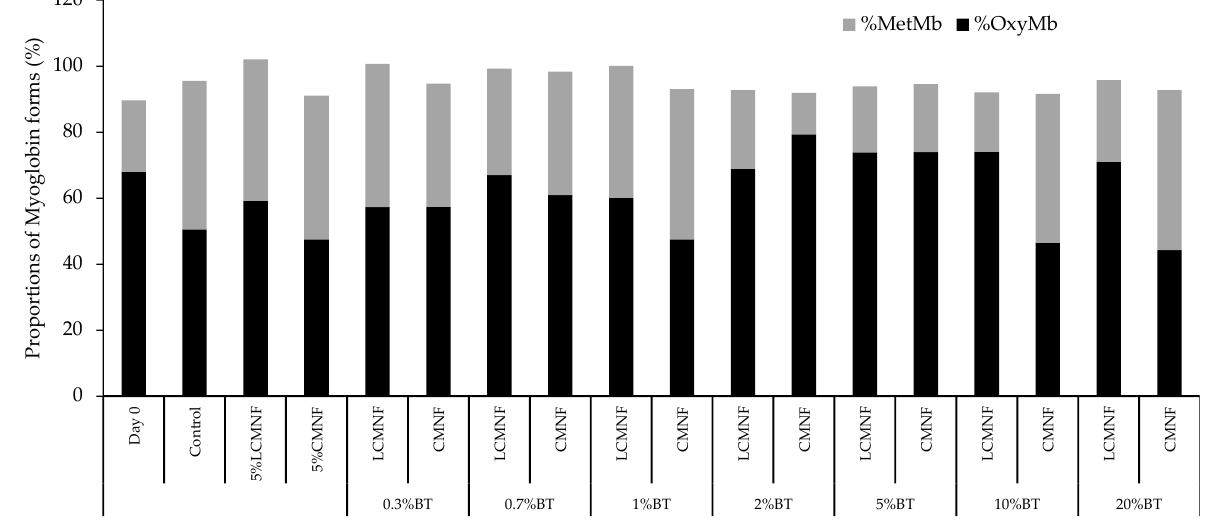
Figure 7. Proportions of oxymyoglobin (%OxyMb) and metmyoglobin (%MetMb) in the raw minced red meat (day 0) and in the meat after 10 days of storage.